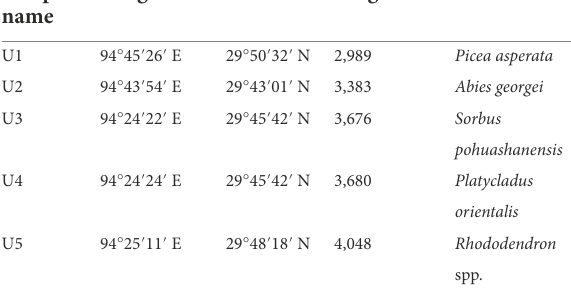
TABLE 1 Information on sources of the samples used in this